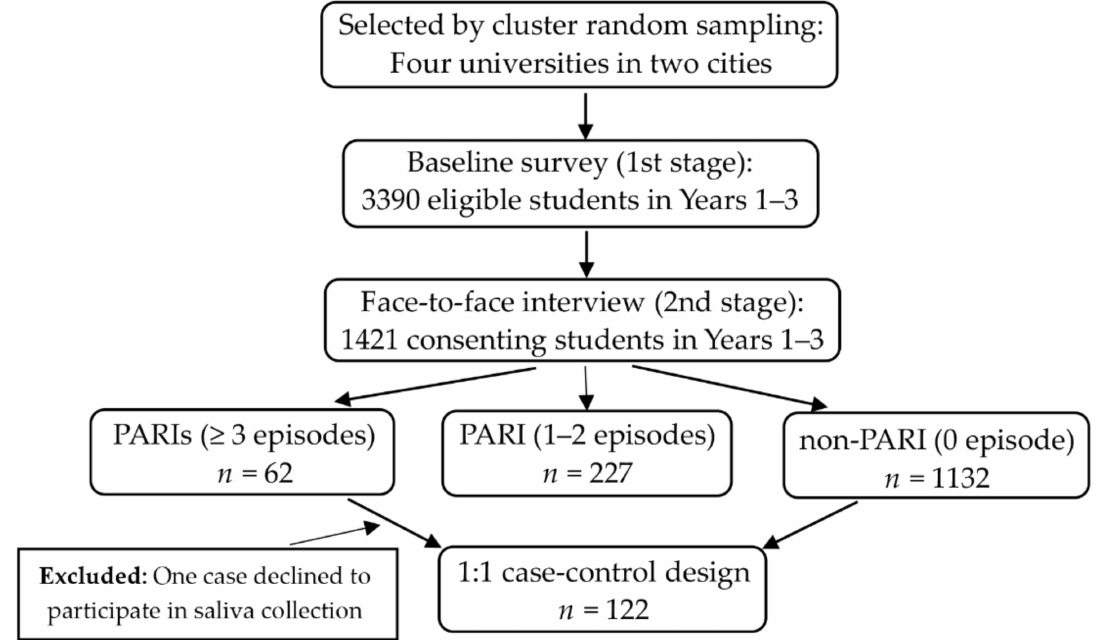
Figure 1. Flow diagram of participants included in the